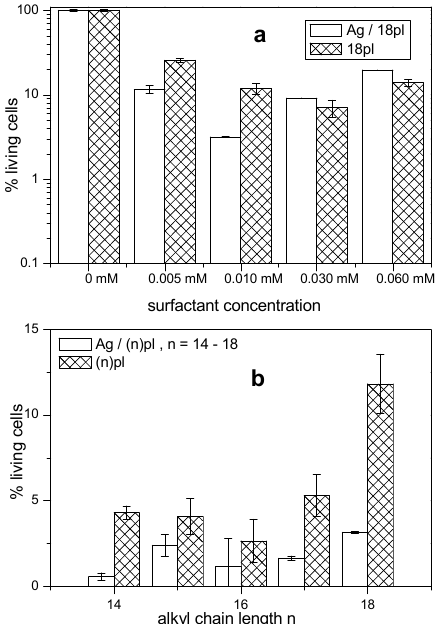
Figure 10. ( a ): Cytotoxicity of Ag/ 18pl nanodispersion and 18pl surfactant solution. ( b ): Cytotoxicity plotted against alkyl chain length represented by the number of carbon atoms in hydrocarbon chain at the surfactant concentration 0.01 mmol/L.